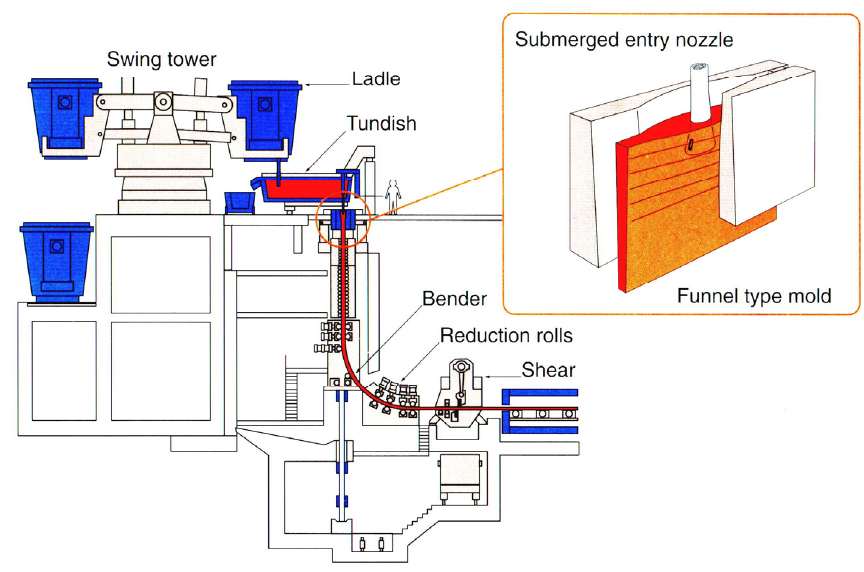
Figure 4. A thin slab caster operation, taken from An Introduction to Iron and steel making [4].